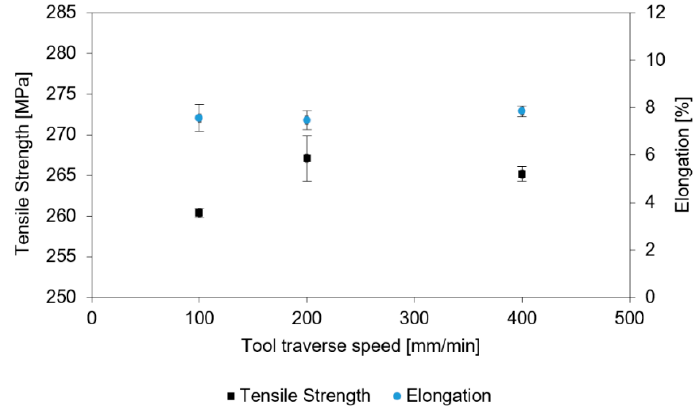
Figure 7. Tensile curves for joints obtained with the tool rotation speed of 800 rpm.